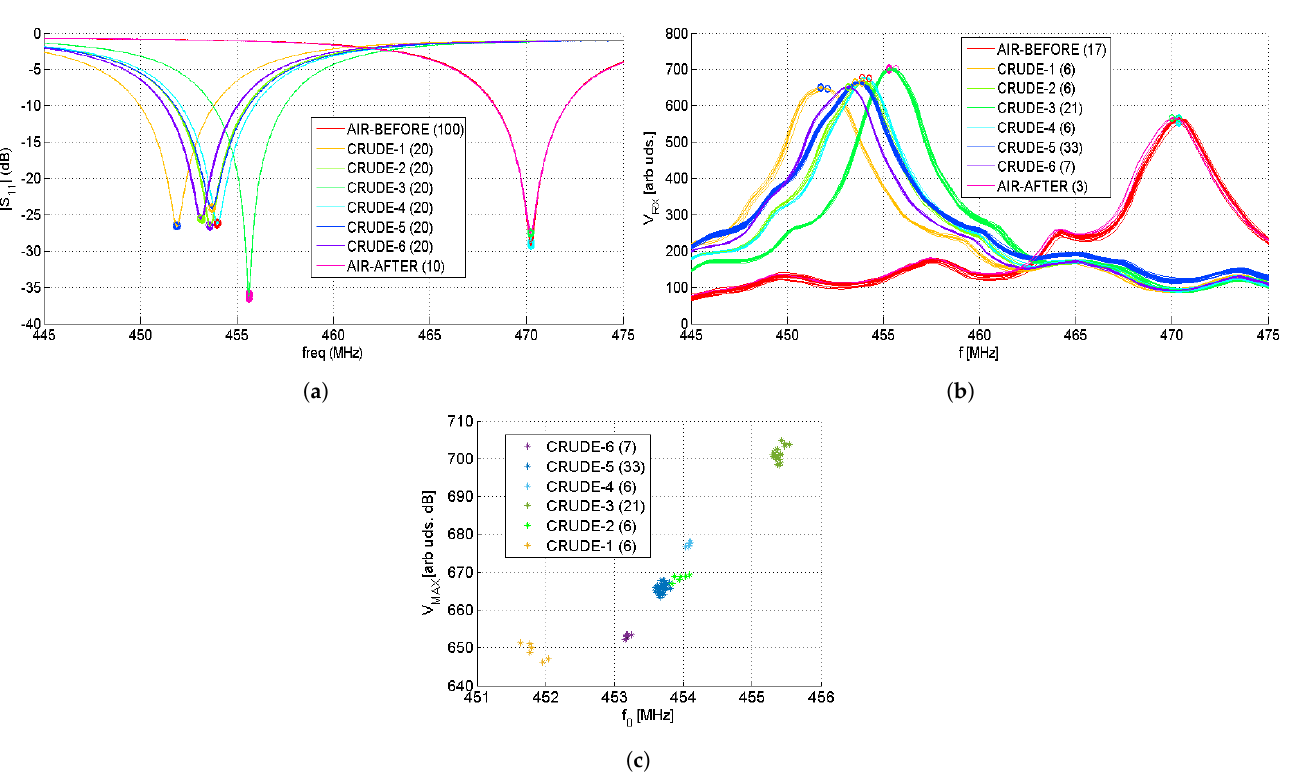
Figure 17. Measurements of six crude samples using the same SRR sensor, the VNA ( a ), and the Interrogator ( b ). The inset shows the number of measurements performed for each sample. The 2D plot of V MAX and f 0 of each measurement ( c ). The air measurements are not